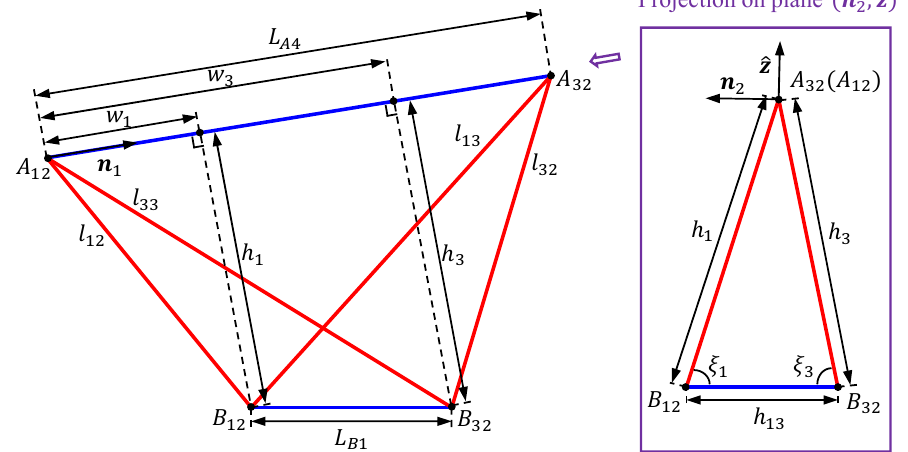
Figure 5. Kinematic diagram of sub-platform 1 for forward